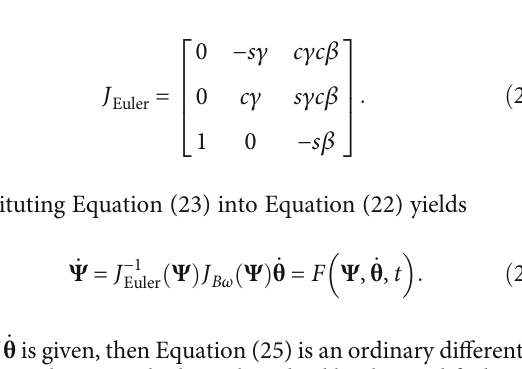
Figure 2: Transformation of the berth